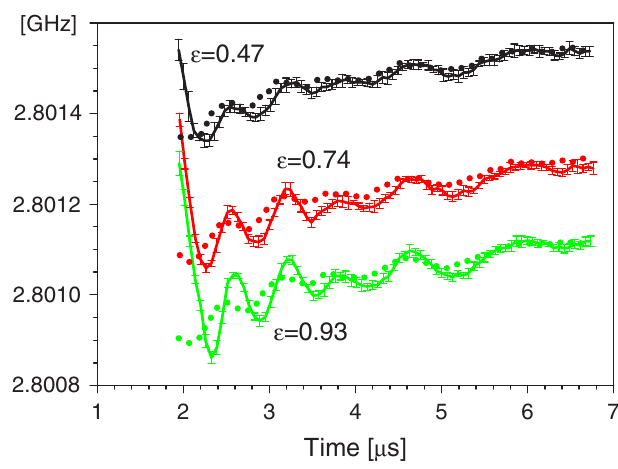
FIG. 11. (Color) Measured deviations in the bunch repetition rate (bold solid lines with error bars) and in the magnetron frequency (dots) for various values of the detuning parameter, "